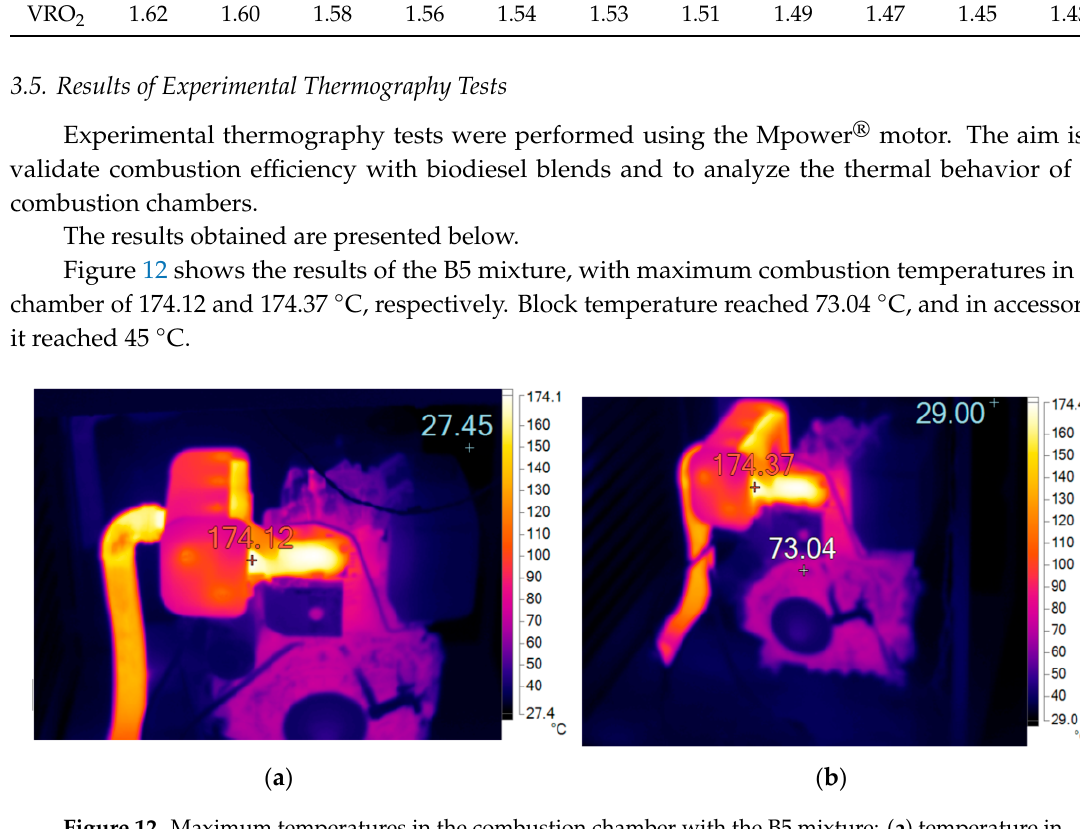
( b ) Figure 13. Maximum temperatures in the combustion chamber with the B10 mixture: ( a ) temperature in the chamber of 175.4 °C; ( b ) temperature in the chamber of 174.6 °C.